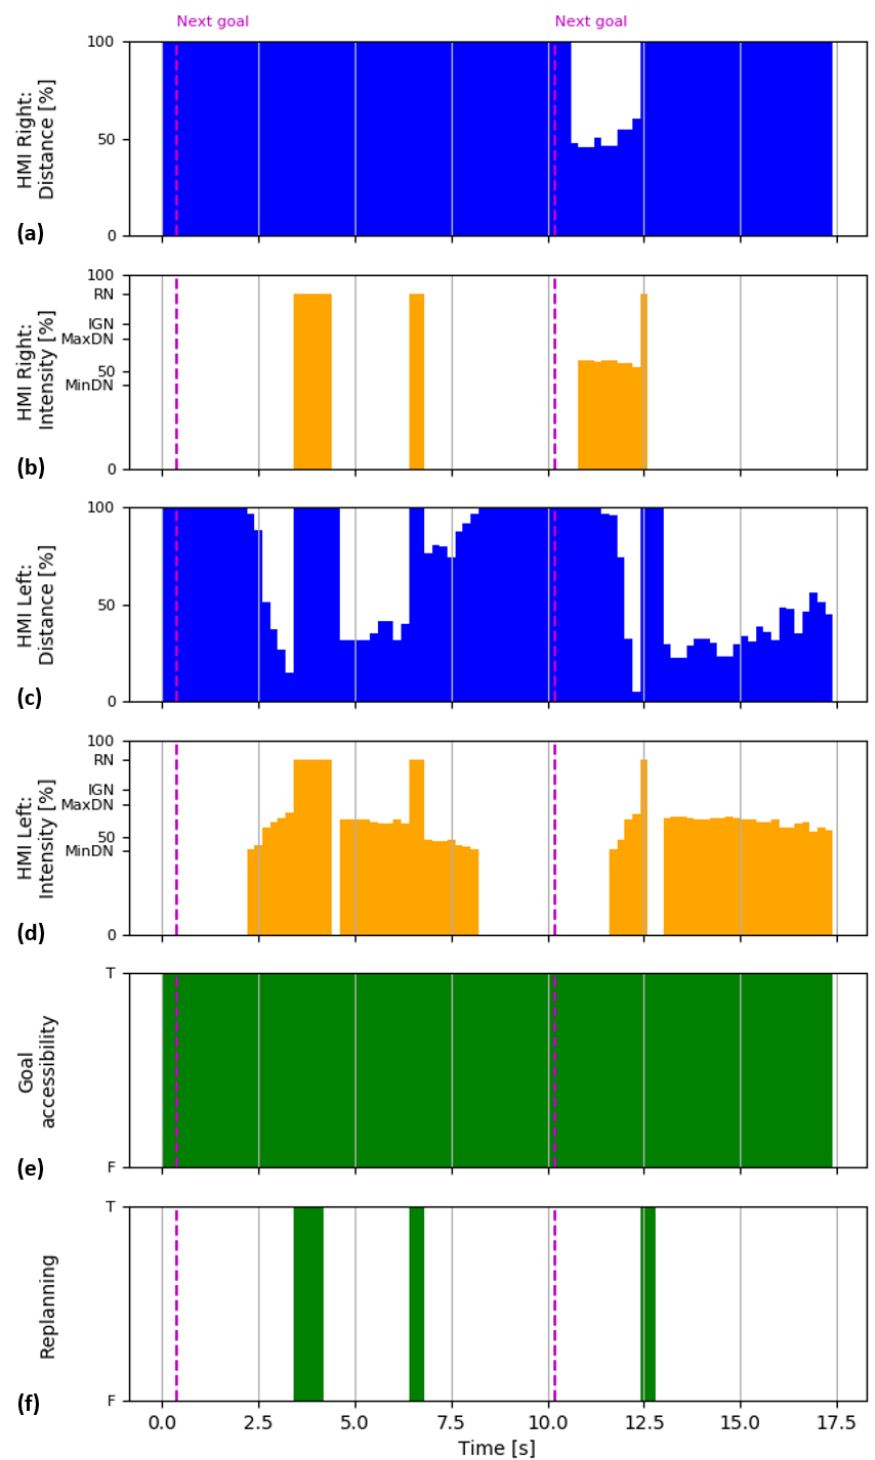
Figure 11. Timeline of the testing on the real workspace: ( a , c ) distances to HMIs displayed as a percentage of reaction distance; ( b , d ) momentary notification intensities displayed as a percentage from the maximum intensity, where RN—replanning notification, IGN—inaccessible goal notifica- tion, MaxDN—maximum distance notification, MinDN—minimum distance notification; ( e ) goal accessibility status where F—false, the planner was not able to find a feasible path to the goal); ( f ) status of replanning routine where T—true, path replanning was required; change of the goal is depicted by the purple dash line.